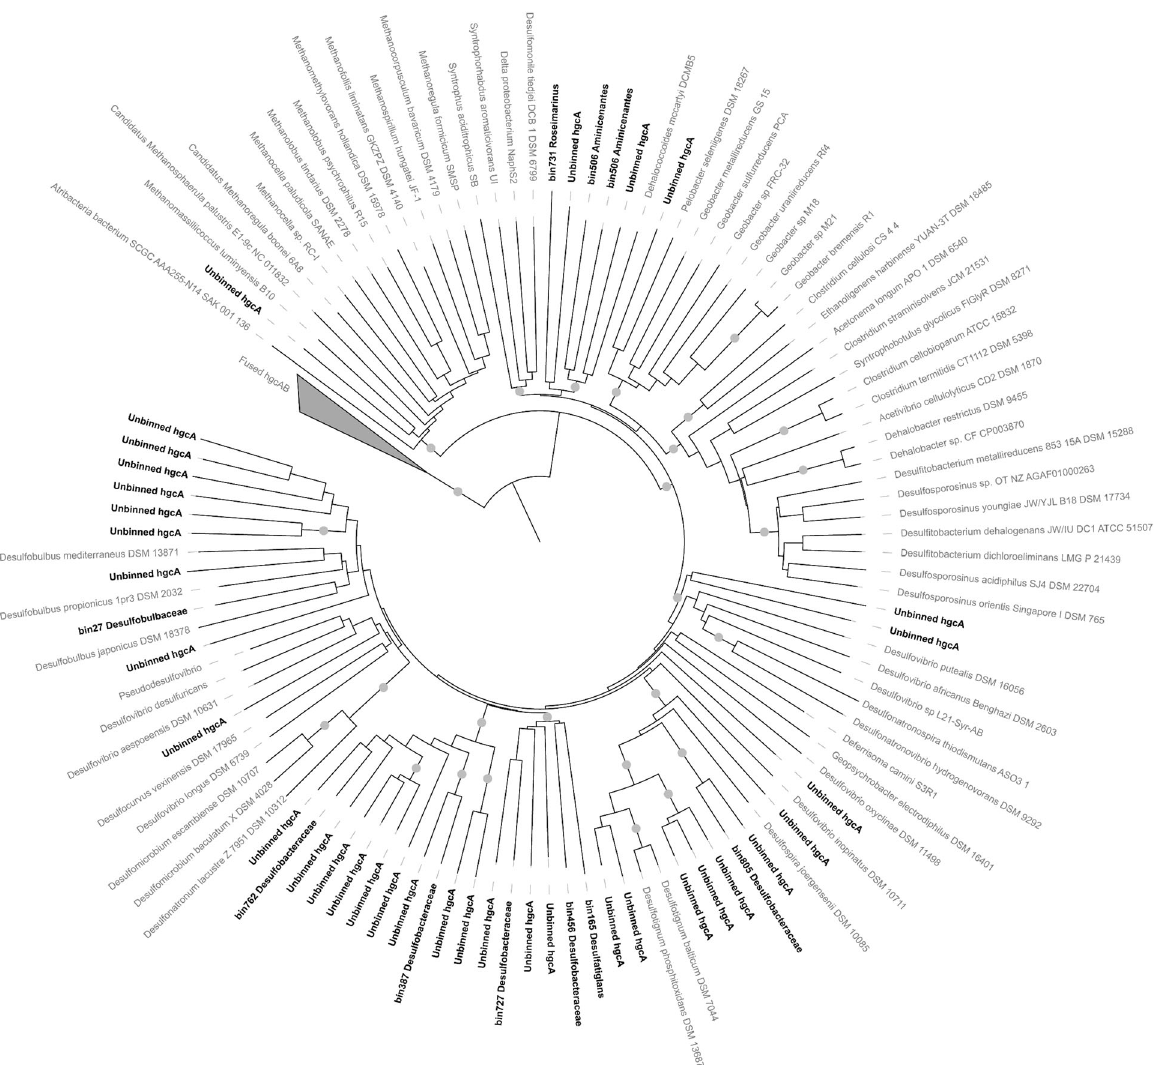
Fig. 4 Phylogenetic tree of the hgcA genes. Binned and unbinned sequences identi fi ed in the metagenomic dataset are in bold. The tree was rooted with the fused hgcAB gene sequences. Bootstraps >0.8 are represented by gray